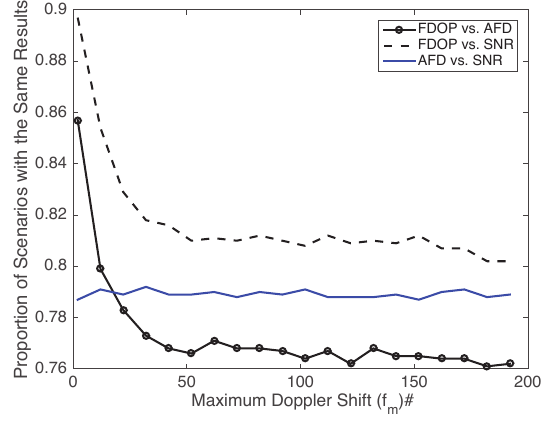
Figure 5. Variation of doppler